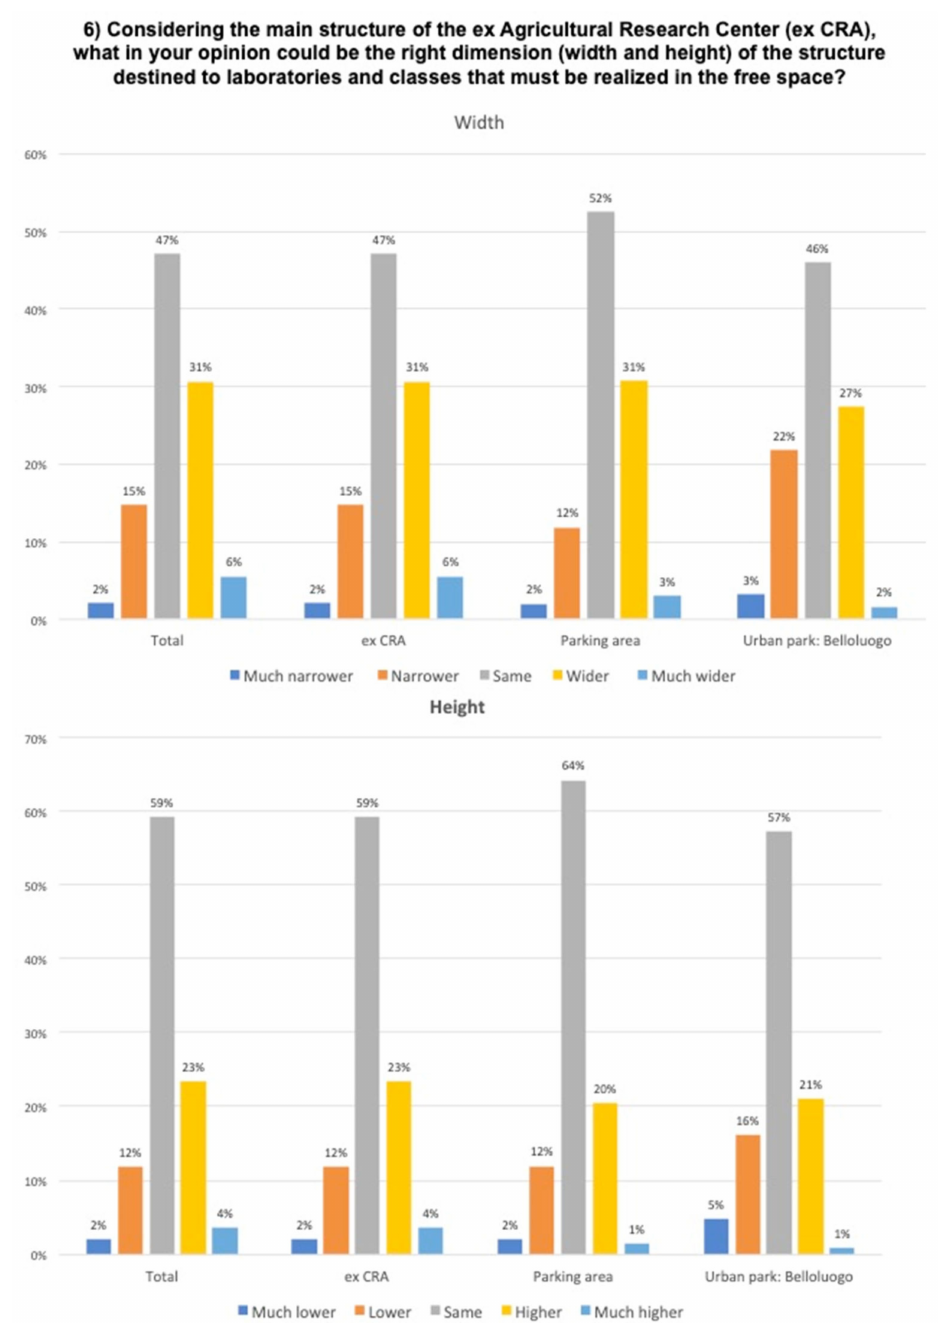
Figure 7. Answers to questions on the possible width and height of the new building that is to be realized within the former